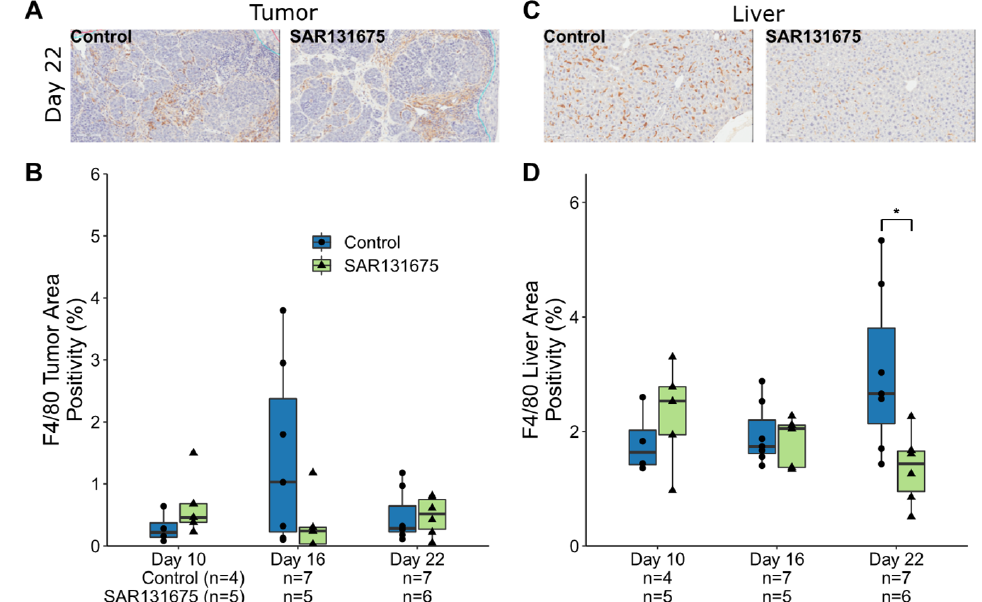
Figure 3. SAR13675 reduces F4/80 + cells in liver parenchyma. Representative IHC images of F4/80 staining cells (brown staining) in control and SAR13675 treated tumor ( A ) and liver ( C ) sections. ( B ) Enumeration of F4/80 positively staining in the tumor as a percentage of total tumor area. ( D ) Enumeration of F4/80 positively staining in liver as a percentage of total liver area. Significance is indicated by * while non-significance is unmarked (* p < 0.05).